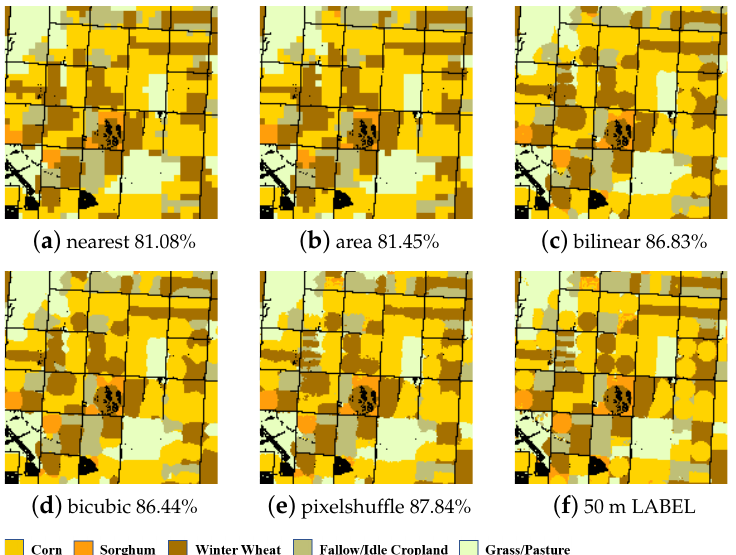
Figure 6. The subfigures ( a – e ) represent the sub-pixel mapping of five different upsampling methods (nearest, area, bilinear, bicubic and pixelshuffle) implemented on a small portion of the Sherman dataset, including the test accuracy they achieved. And ( f ) is the corresponding label. It shows that the pixelshuffle layer is more capable of generating sub-pixel maps even in fragmentary parcels and limited crop